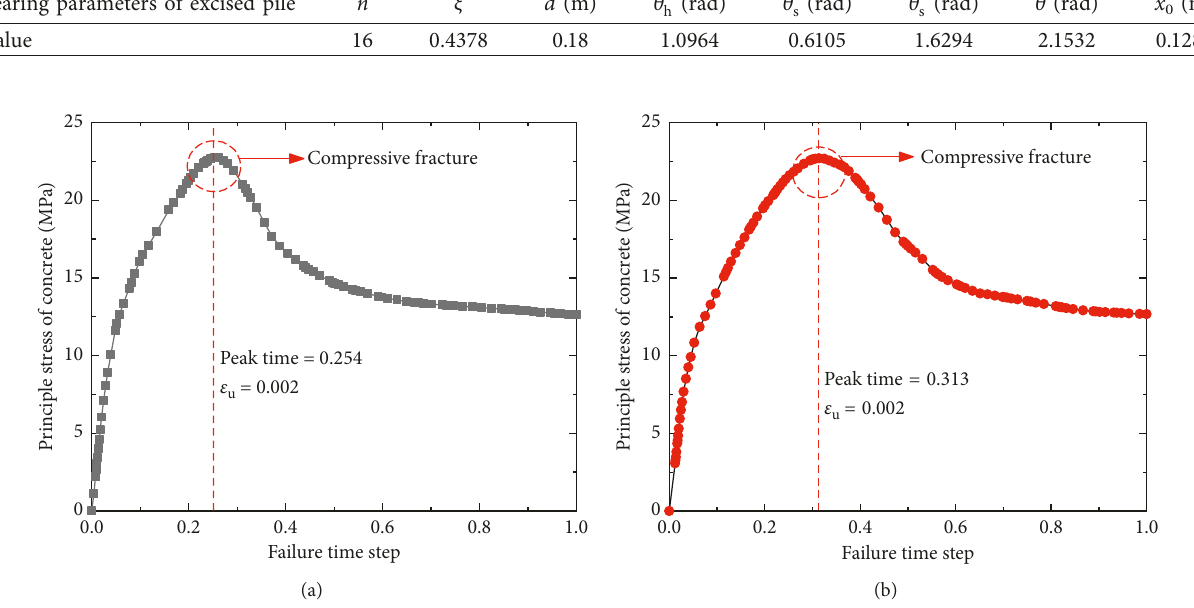
Figure 10: Relation curve of compressive stress related to failure time step: (a) compressive concrete element of the complete pile and (b) compressive concrete element of the excised pile.